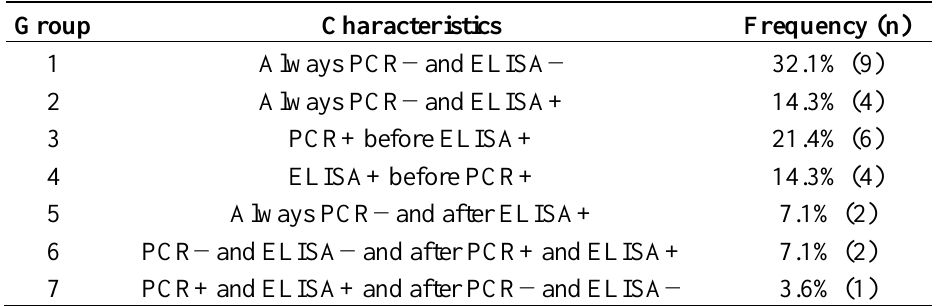
Table 2. Classification into groups of the sheep according to the evolution of the viral infection (PCR) and humoral immune response (ELISA) in milk throughout the study period (December through